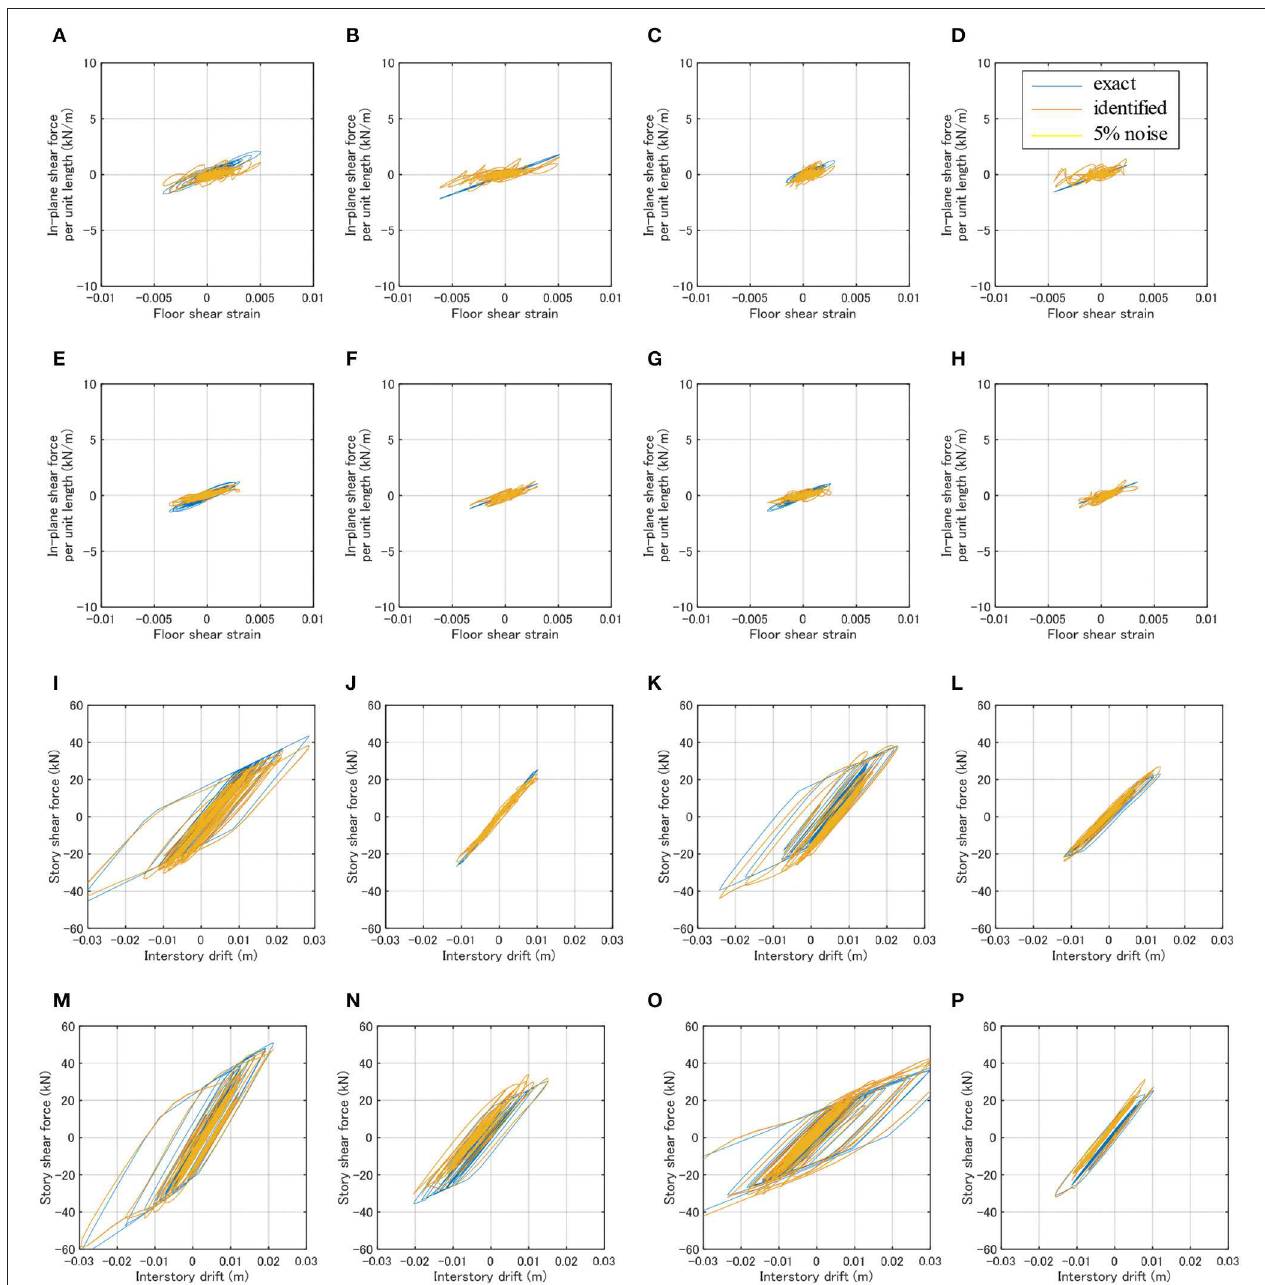
FIGURE 10 | Identification results for case with noise (El Centro 1940 NS). (A) H-frame (x1y1_1F). (B) H-frame (x1y2_1F). (C) H-frame (x2y1_1F). (D) H-frame (x2y2_1F). (E) H-frame (x1y1_2F). (F) H-frame (x1y2_2F). (G) H-frame (x2y1_2F). (H) H-frame (x2y2_2F). (I) V-frame (x1_1F). (J) V-frame (x1_2F). (K) V-frame (x3_1F). (L) V-frame (x3_2F). (M) V-frame (y1_1F). (N) V-frame (y1_2F). (O) V-frame (y3_1F). (P) V-frame (y3_2F).